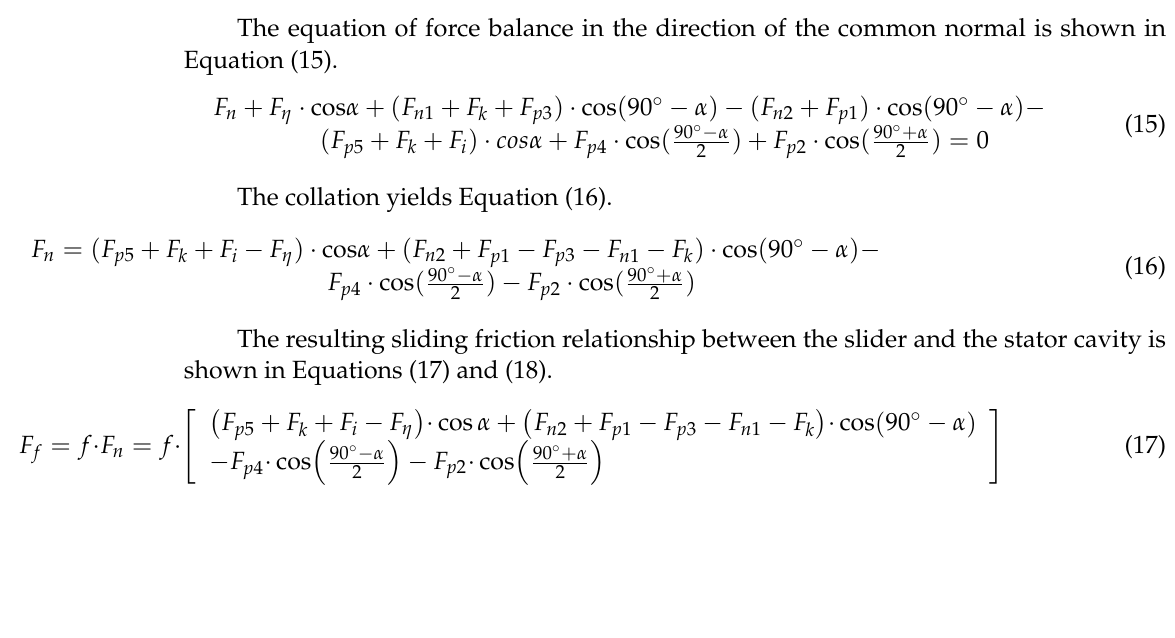
Figure 4. Slider transition chamber force analysis diagram.